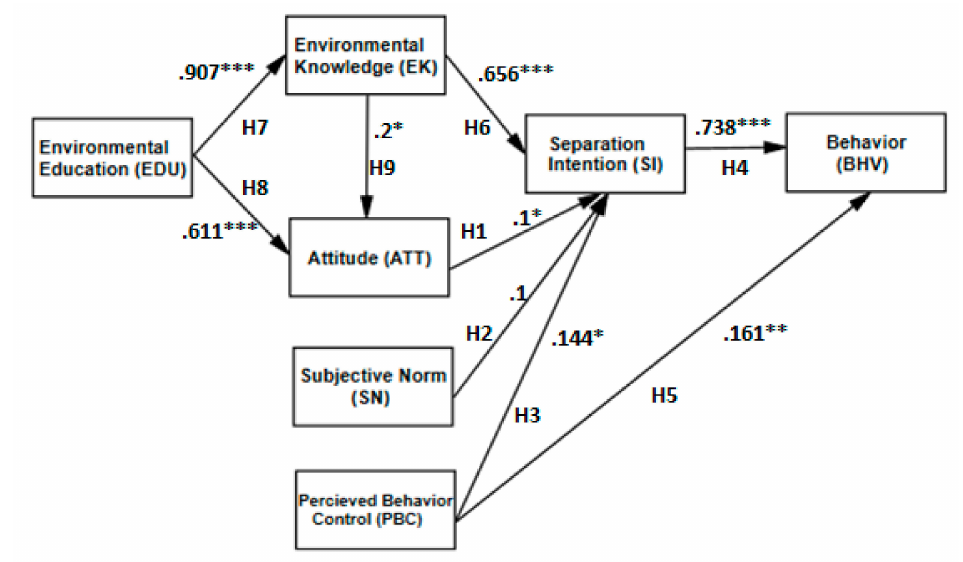
Figure 2. The casual relationship between study constructs and separation of solid waste on campus. Note: *** p < 0.001, ** means p < 0.01, and * means p <